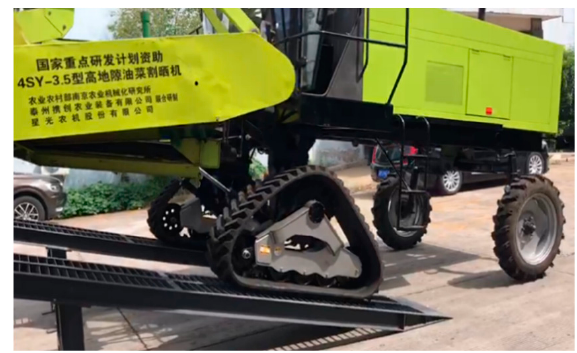
Figure 19. Running on rice stubble field.